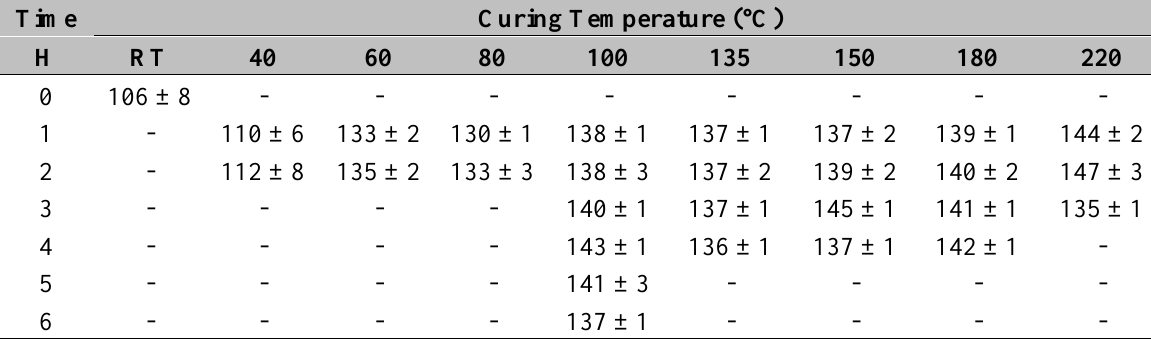
Table 1. Static water contact angle values (°) for non-cured and cured modified MFC films with different temperatures and